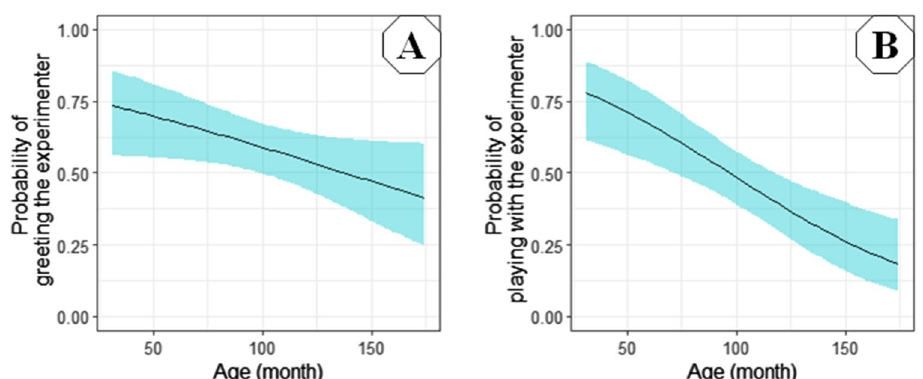
Figure 6. Probability of greeting the experimenter without her needing to call the dog ( A ) and playing more enthusiastically with her ( B ), according to age in months. Younger dogs were more likely to greet the experimenter and had higher playfulness, than the older ones.